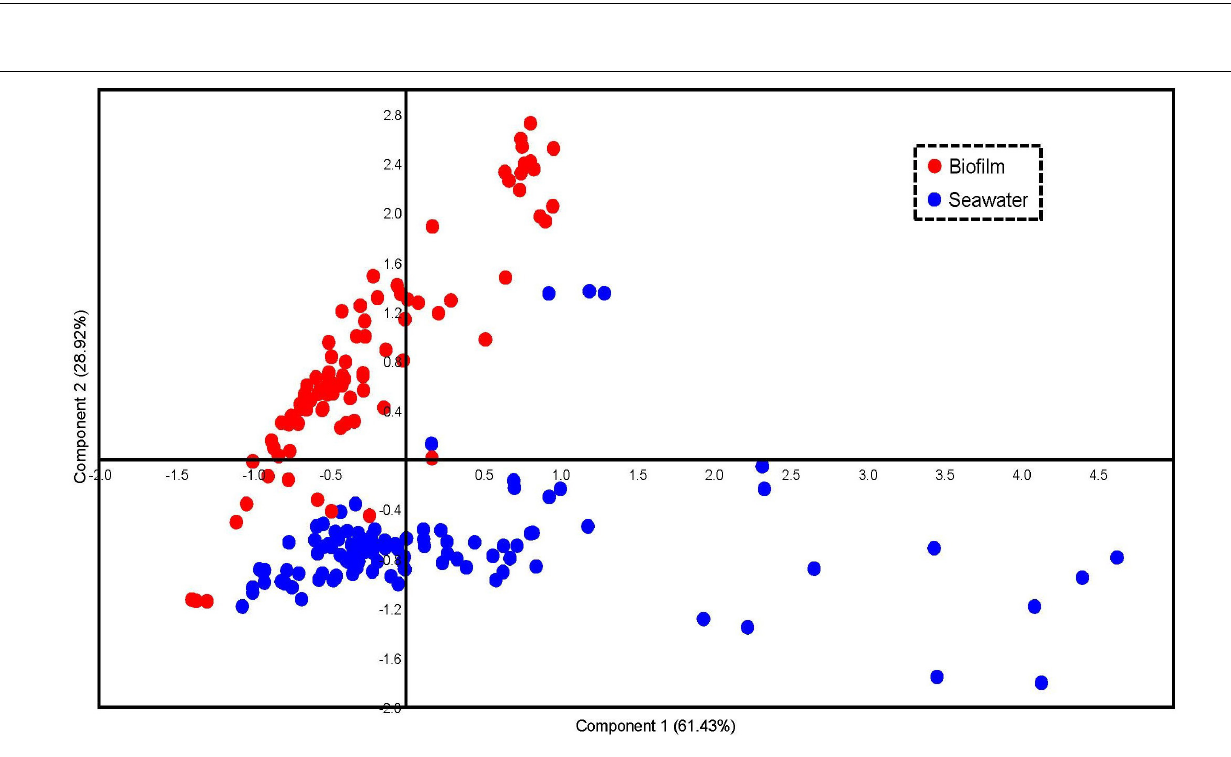
Frontiers in Microbiology |